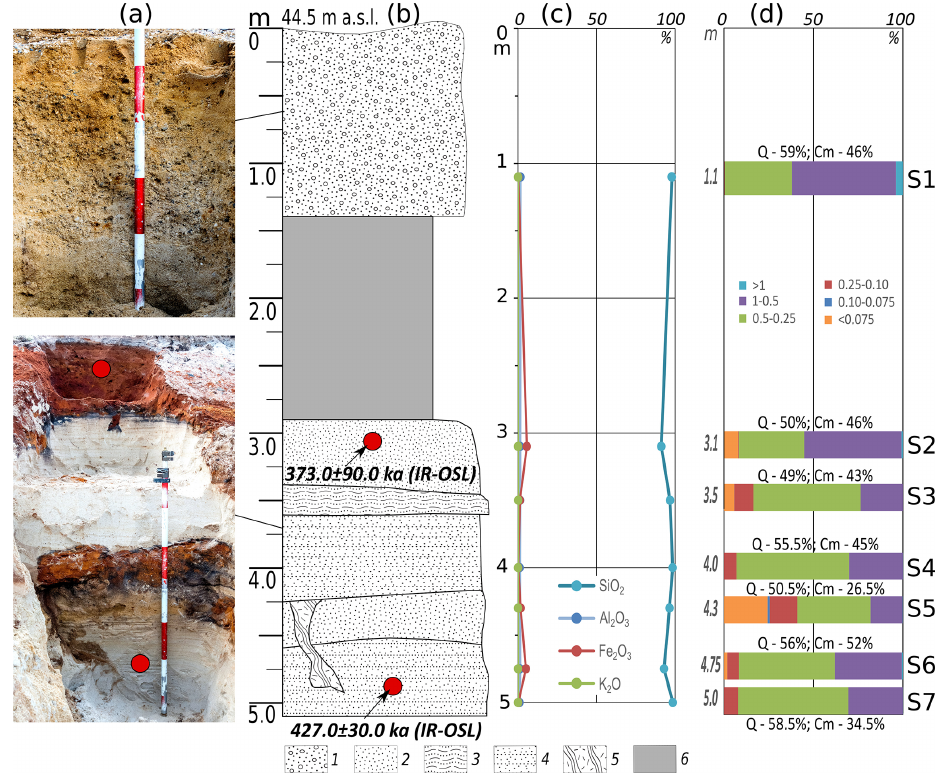
Figure 5. Summary results of research for NS-13/14 section: (a) photographs (by Sizov in 2017); (b) geological structure and the dating results (see Table 32); (c) bulk chemical data; (d) grain size distribution (fractions,mm). Symbols: (1) coarse sand with pebbles; (2) unstrat- ified red sand; (3) undulating black sand; (4) horizontally layered sand; (5) wedge filled by deposits of the overlying layer; (6) colluviums; Q : coefficient of roundness of the sand quartz grain; Cm: degree of dullness; S: sample number. Table 3. IR-OSL ages and the related analytical data for the sediment samples from the sites studied. Absolute dating by the IR-OSL method Section Sampling depth Sample code Age U (ppm) Th (ppm) K